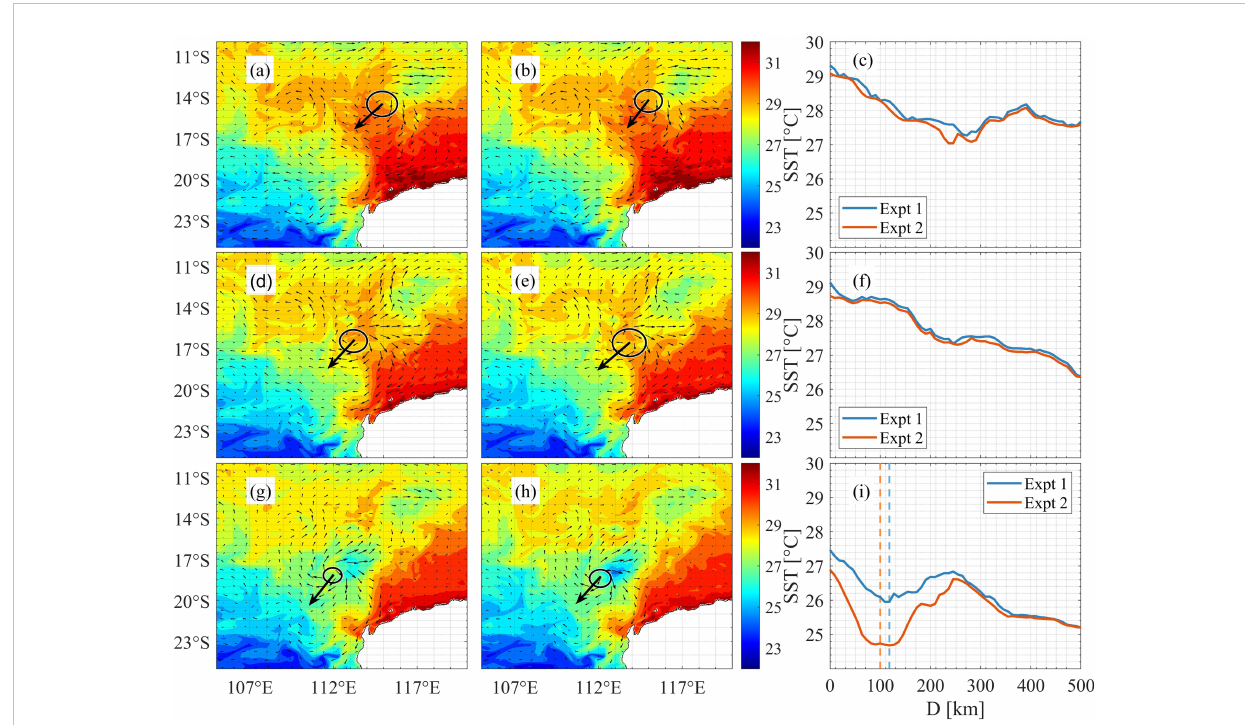
FIGURE 8 (A, D, G) are sea surface temperature (SST) without the spume scheme on 10 – 12 January 2013. (B, E, H) are the same as (A, D, G) but with the spume scheme. (C, F, I) represent the azimuthal averages of SST. The direction in which TC Narelle is moving forward at different times is demonstrated by the red arrows. The vectors are the directions of the local currents. The azimuthal minimum of SST is shown by solid lines. The radius of maximum wind is represented by solid circles and dashed lines in spatial distributions and azimuthal averages,